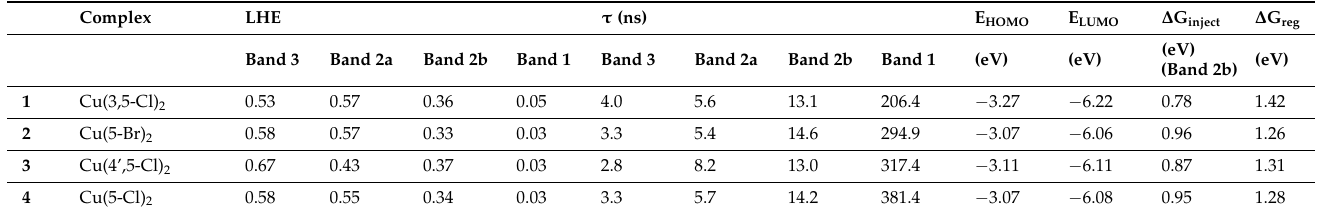
Table 3. B3LYP/6-311G(d,p)/def2-TZVPP calculated light harvesting efficiency (LHE), excited